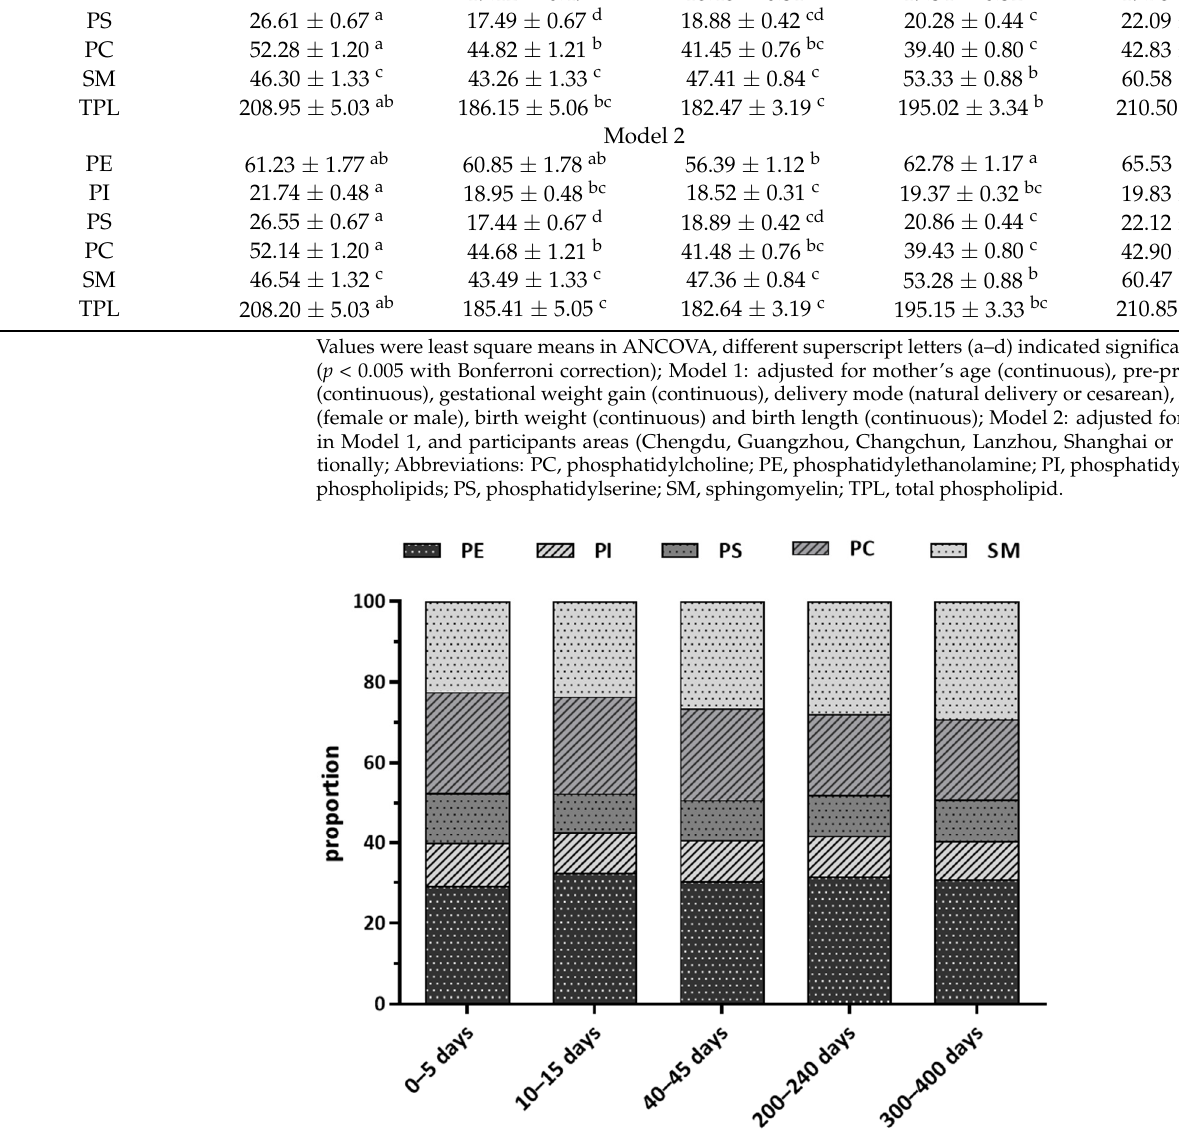
Figure 2. Proportion of components in total phospholipid at different lactation stage (%). PC, phos- phatidylcholine; PE, phosphatidylethanolamine; PI, phosphatidylinositol; PS, phosphatidylserine; SM, sphingomyelin.